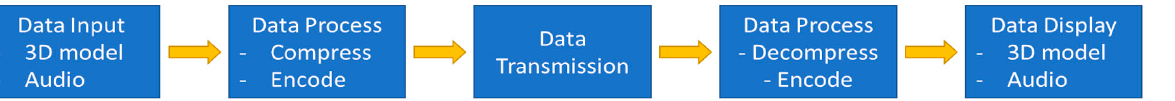
Figure 4. The framework of real-time 3D reconstruction for holographic telepresence.